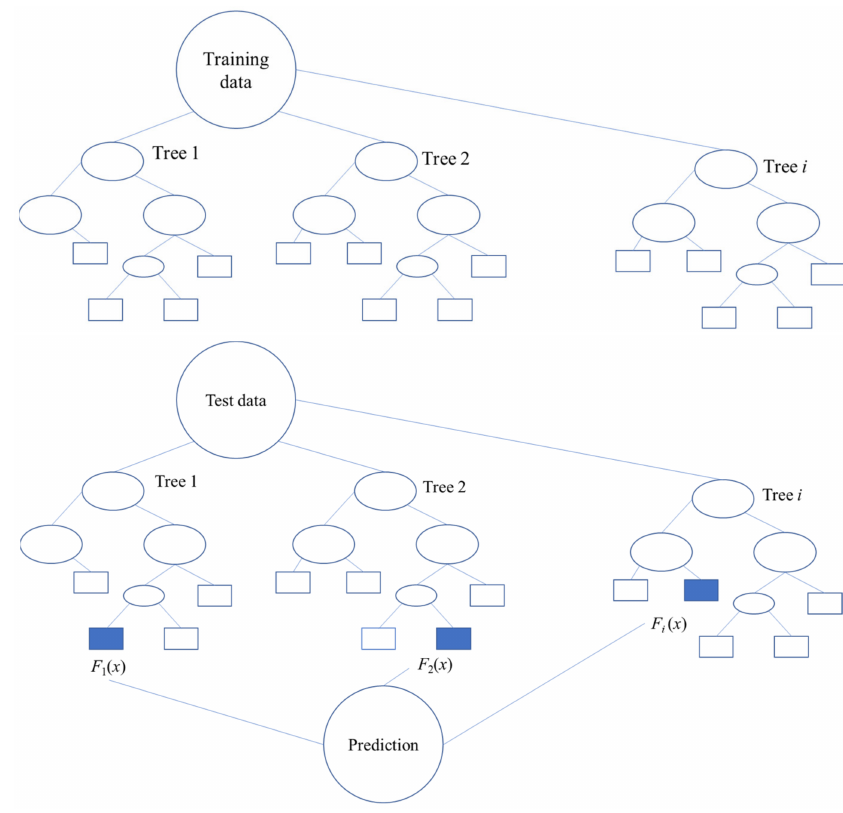
Figure 2. Typical Random Forest tree (adapted from [26]).